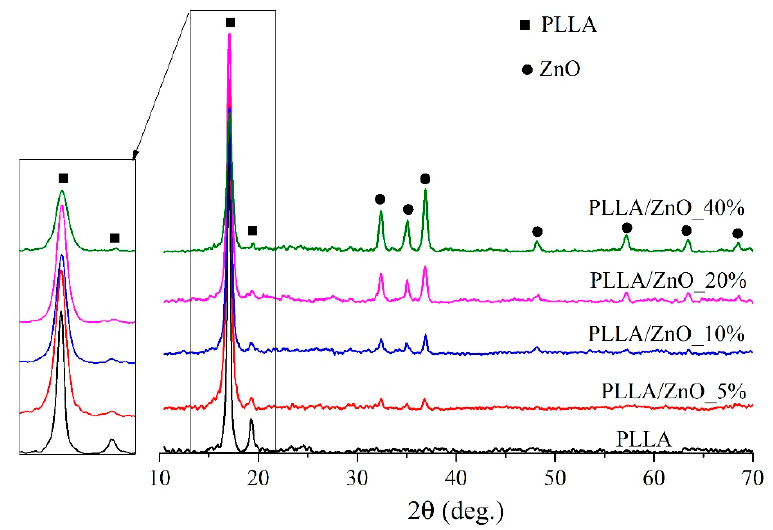
Figure 3. X-ray diffraction patterns of PLLA and PLLA/ZnO composite membranes.